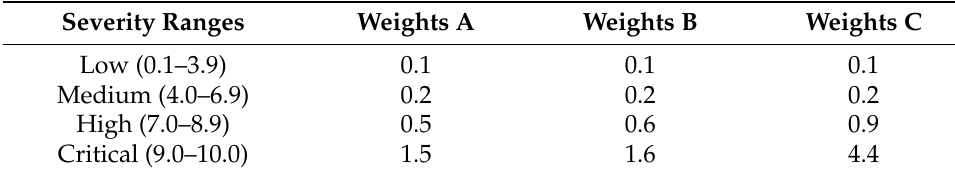
Figure 3. VERCASM-CPS Database Workflow. Table 3. Weights assigned per